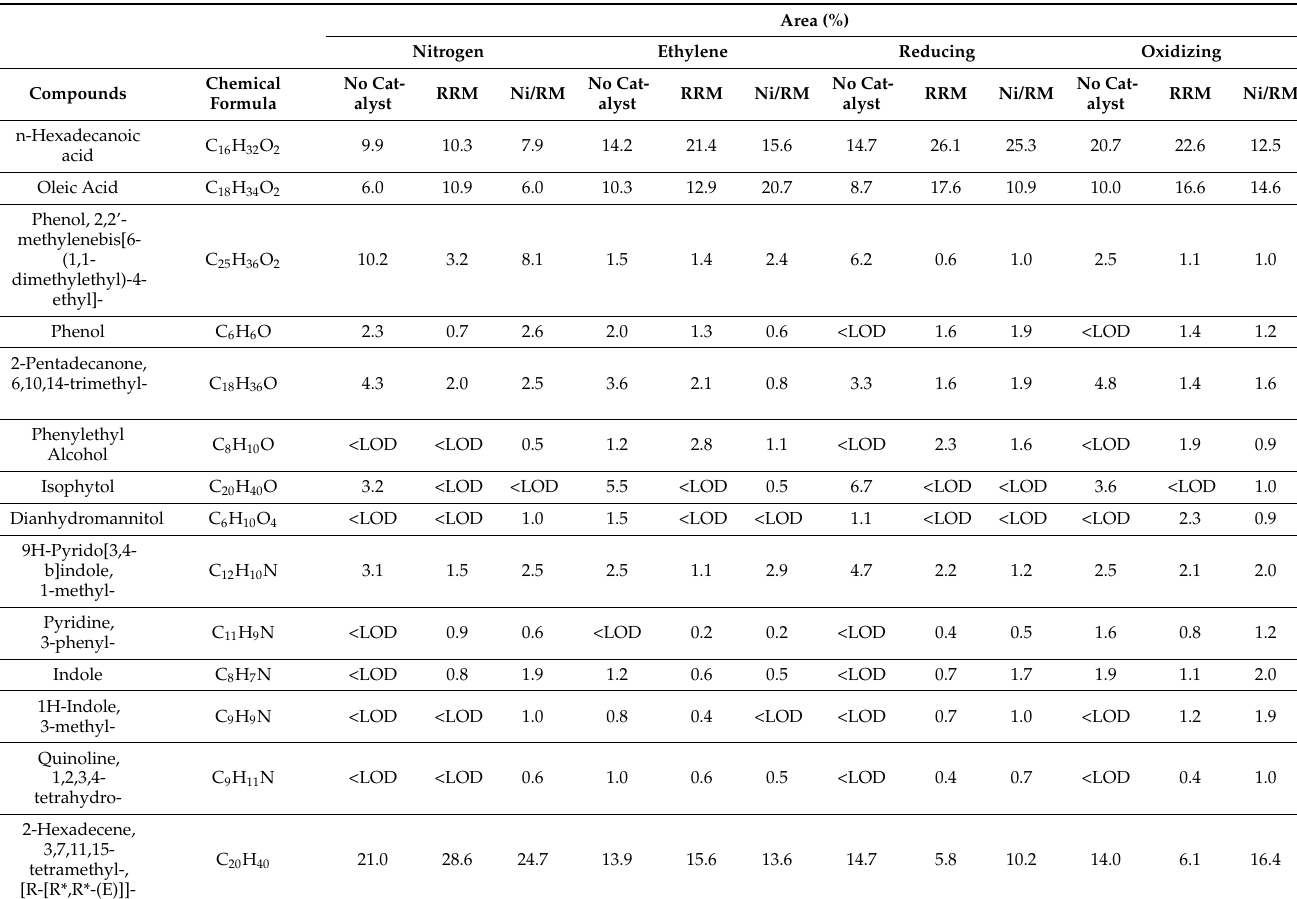
Table 3. GC-MS analysis of Tetraselmis HTL